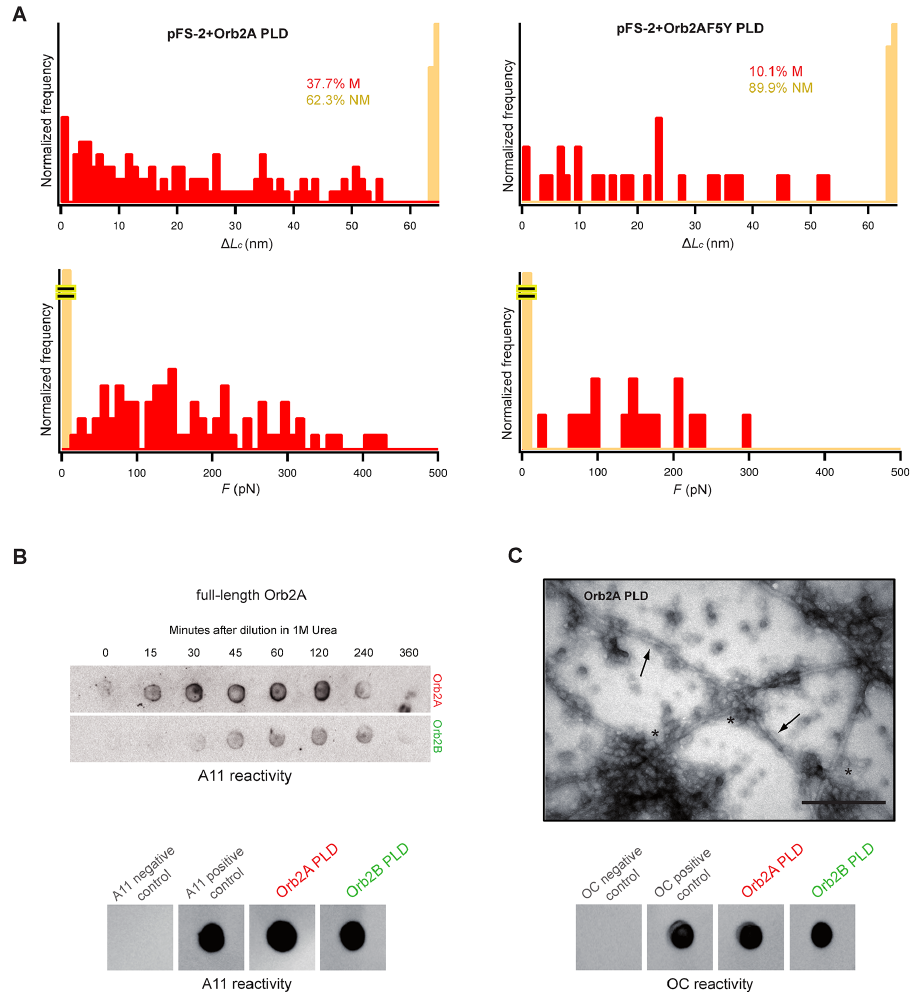
Fig 4. Orb2 shares common features with the pathological amyloidogenic pathway. (A) Δ L c and F SMFS histograms of pFS-2 polyproteins carrying the Q/N-rich PLD of Orb2A show a broad mechanical polymorphism in terms of the increased contour length ( Δ L c , top) and mechanical stability (bottom), ranging from NM conformers (orange bars) to different M conformers (red bars, n = 106), similar to that found in pathological amyloids [41]. In line with its reduced ability to form amyloids (see Fig 3 and S4 Fig), the mechanical conformational polymorphism of the F5Y mutant is diminished, increasing the proportion of NM conformers ( n = 109). (B) Immunodot blot showed that like toxic oligomeric intermediates of other amyloidogenic proteins, both full-length Orb2A, and to a lesser extent Orb2B, as well as their isolated PLDs, are recognized by the A11 antibody [45]. (C) A representative electron micrograph of aged Orb2A PLD shows the formation oligomers (asterisks) and typical unbranched amyloid fibers (arrows) resembling those of the full-length Orb2A (see Fig 1G) and pathological amyloids. Scale bar: 0.2 μ m. Like pathological amyloids, those species are recognized by the fiber-specific OC monoclonal antibody [46]. For panels B and C, A β 42 oligomers and fibers were used as positive controls for the A11 and OC antibodies, respectively, while ubiquitin was used as a negative control. The underlying data for panels in this figure can be found in S1